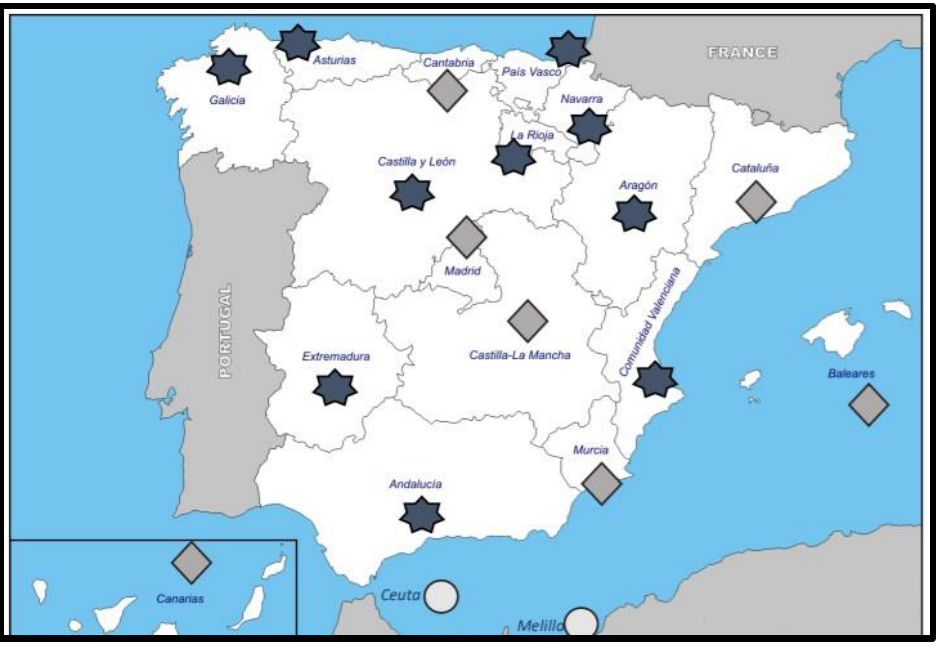
Figure 1. Spanish Figure 1. Spanish provinces.